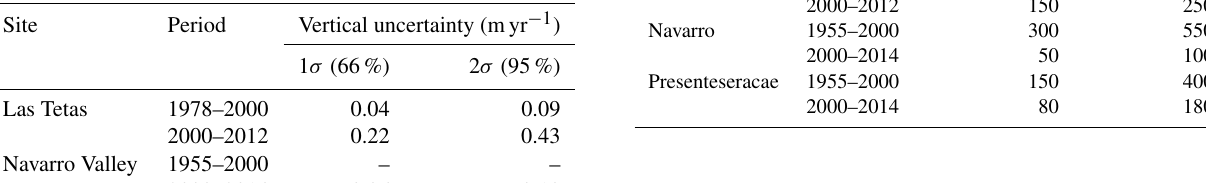
Table 2. Uncertainty related to the measurement of annual elevation changes. Reported uncertainties correspond to 1 and 2-standard de- viation ( σ ) probability of vertical errors for the generated DEMs. In Navarro Valley, no reliable DEM could be generated from the 1955 aerial photos, which explains the absence of data in the table for the 1955–2000 interval.